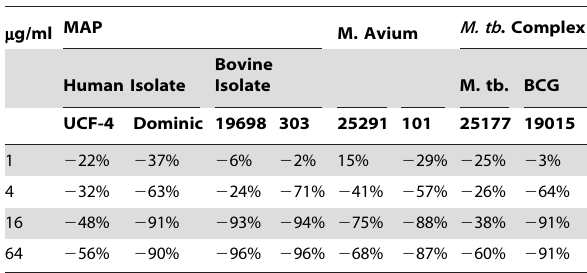
Table 4. Vitamin D Cholecalciferol.